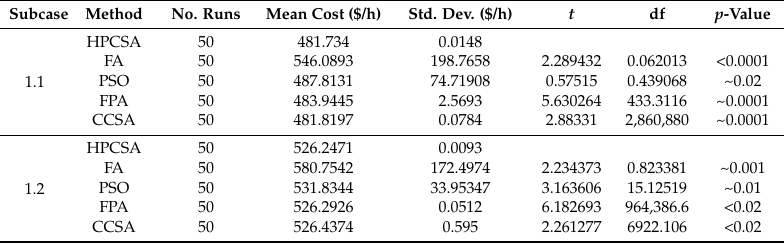
Table 11. p values of Welch’s t -test for comparison of the proposed method and others for case 1. Subcase